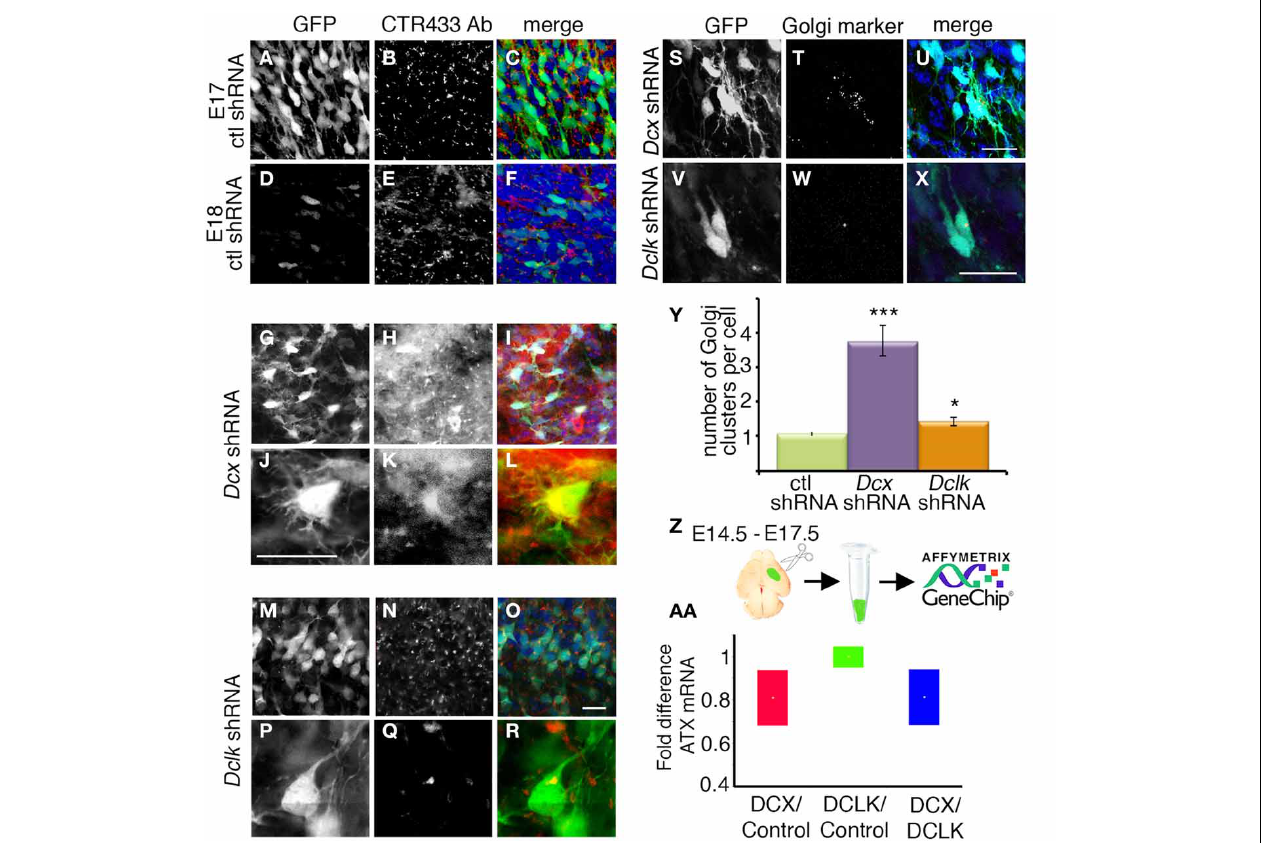
FIGURE 2 | (A–X) The organization of the Golgi apparatus in Dcx and Dclk shRNA transfected neurons stalled in the IZ. (A–R) Golgi organization is shown by Golgi specific immunostaining. Control (A–F) , Dcx (G–L) or Dclk (M–R) shRNA were electroporated brains (E14–E18) were immunostained with CTR433 Golgi antibodies. Since there are practically no cells in the area of interest (IZ) in the control experiment, an additional control was used, in which the control shRNA was electroporated from E14 to E17, when some control cells still reside in the IZ (A–C) . GFP (A,D,G,J,M,P) serves as a marker for electroporated cells. (S–X) Verification of Golgi organization shown by coelectroporation with a plasmid expressing a Golgi marker. Dcx (S–U) or Dclk (V–X) shRNA were coelectroporated with a Golgi marker plasmid, 82 amino acids of β 1,4-Galactosyltransferase fused